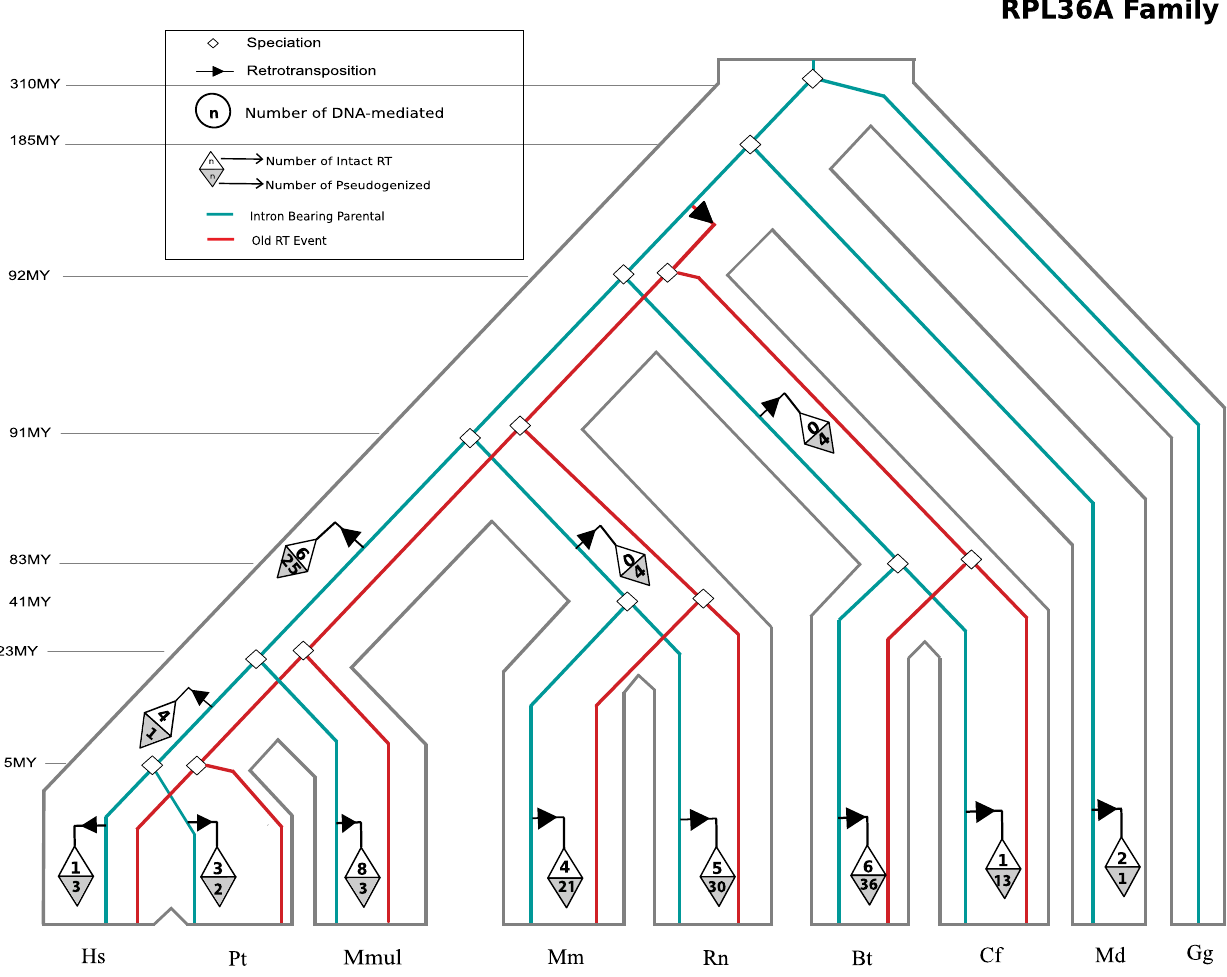
Figure 3. Example of the inferred evolutionary history for duplications of the ribosomal protein gene Rpl36a. Grey outlined tube tree represents the species tree that includes 8 mammals and chicken. Parental intron-bearing gene (in blue). RT-RPs (clear triangles), R Y -RPs (grey triangles). An RT-RP duplicate generated from one of these events, Rpl36al (in red, at the base of the mammalian lineage on the branch between LCA with opossum and the other mammals) is conserved in all descendent species. All the 74 ribosomal protein gene family history trees are attached as supplementary material.